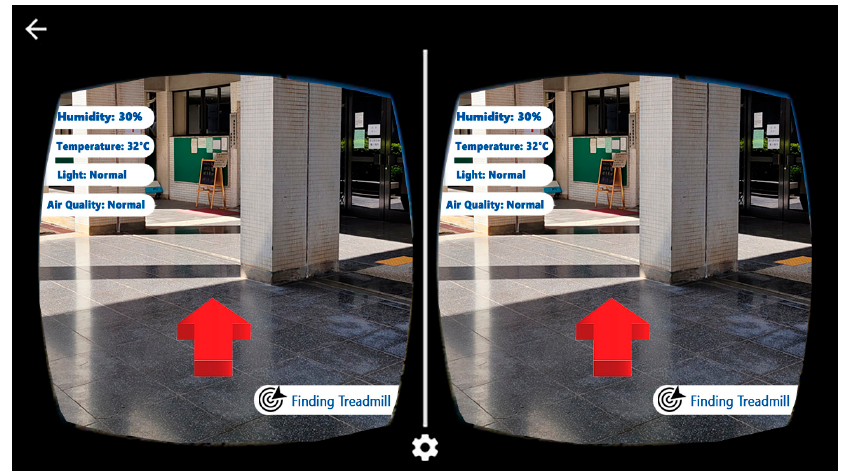
Figure 18. Screenshot of GAR HMD mode. (The left arrow in the upper left corner indicates the “EXIT” button to exit the app.) “EXIT” button to exit the